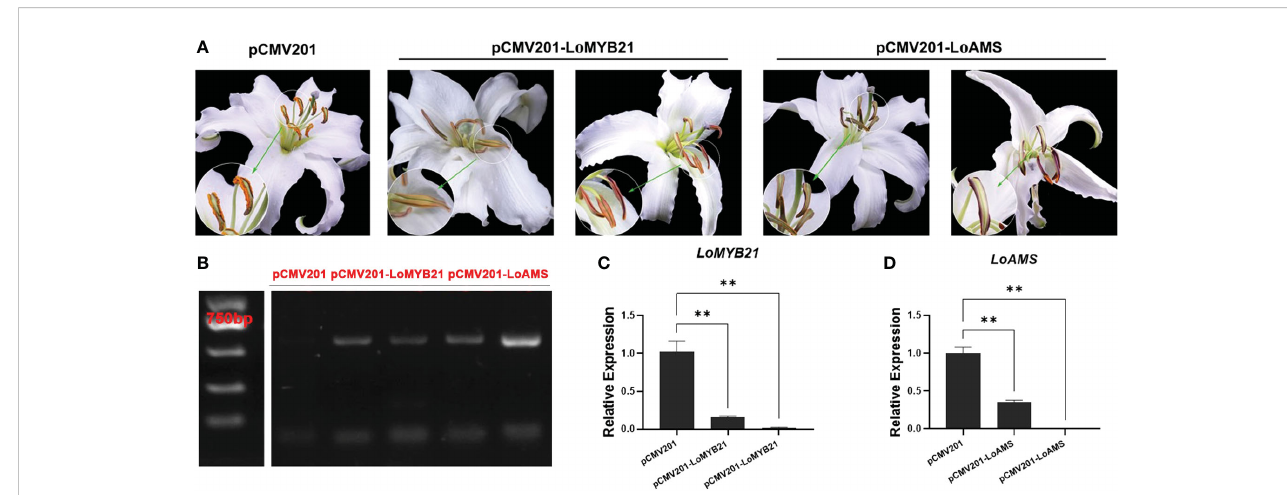
FIGURE 7 Virus-induced silencing of LoMYB and LoAMS in Lilium Oriental Hybrid ‘ Siberia ’ . (A) Anther phenotypes of LoMYB -silenced and LoAMS -silenced plants. (B) Electrophoresis gel plot of the gene sequence encoding the CP protein in the cucumber mosaic virus control plants (transformed with the pCMV201 vector), LoMYB21 -silenced plants, and LoAMS -silenced plants. (C, D) Quantitative real-time PCR analysis of LoMYB21 and LoAMS expressions in the anthers of LoMYB21 -silenced and LoAMS -silenced